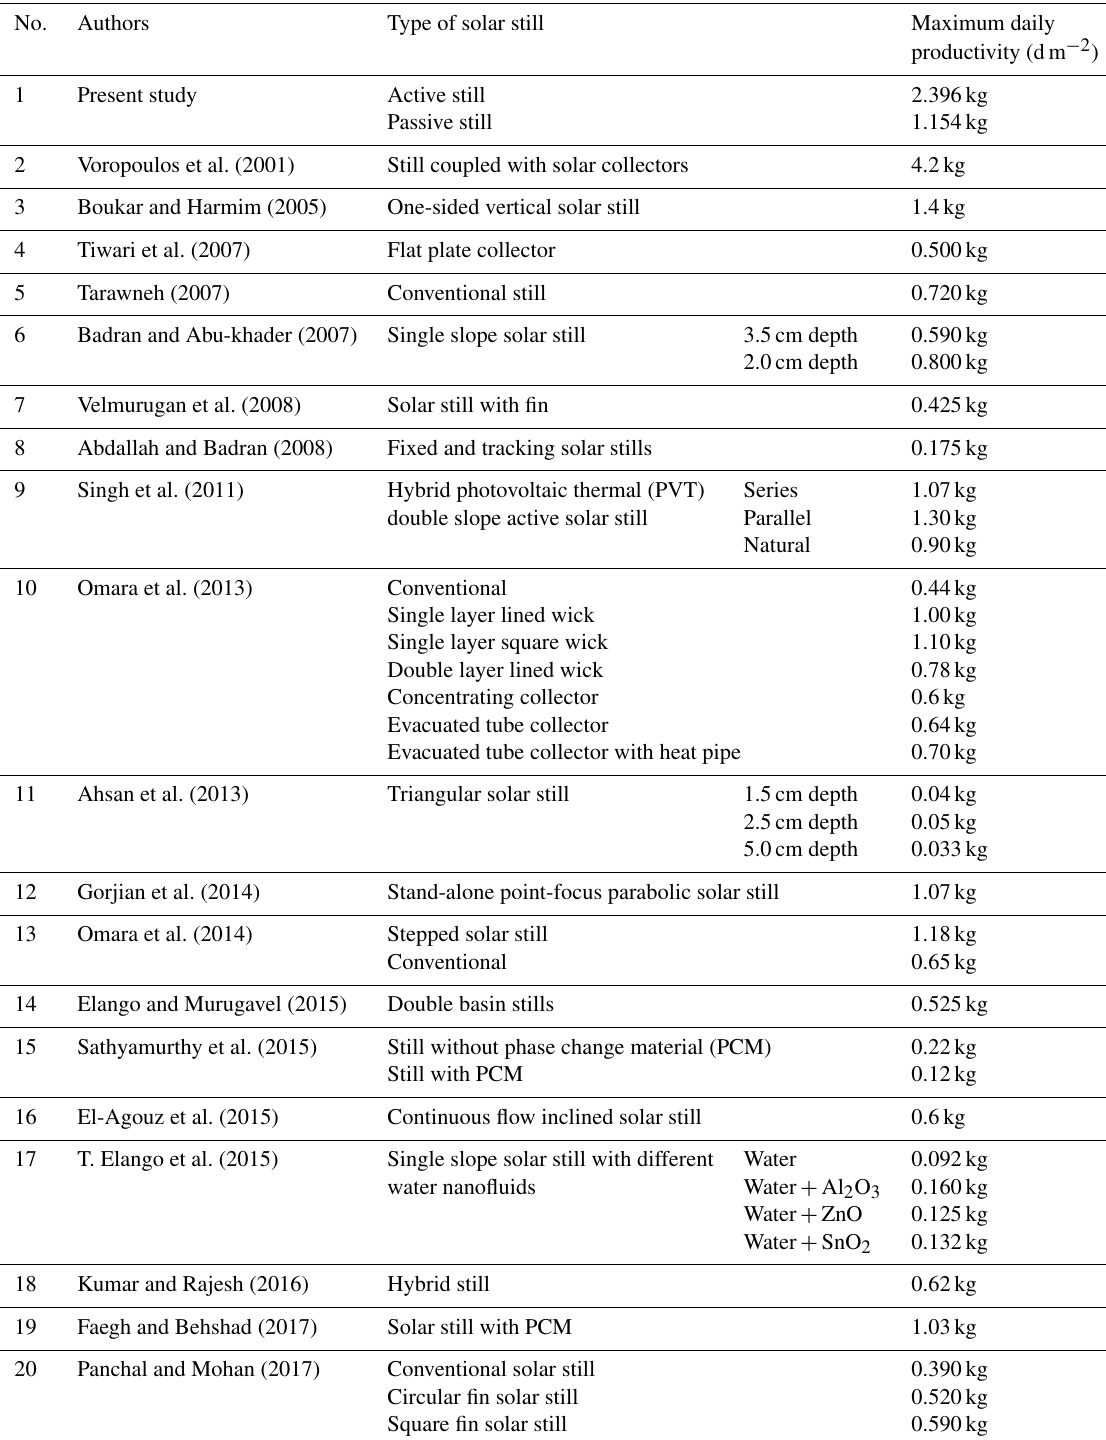
Table 2. Performance comparison of the solar still in terms of maximum daily productivity.